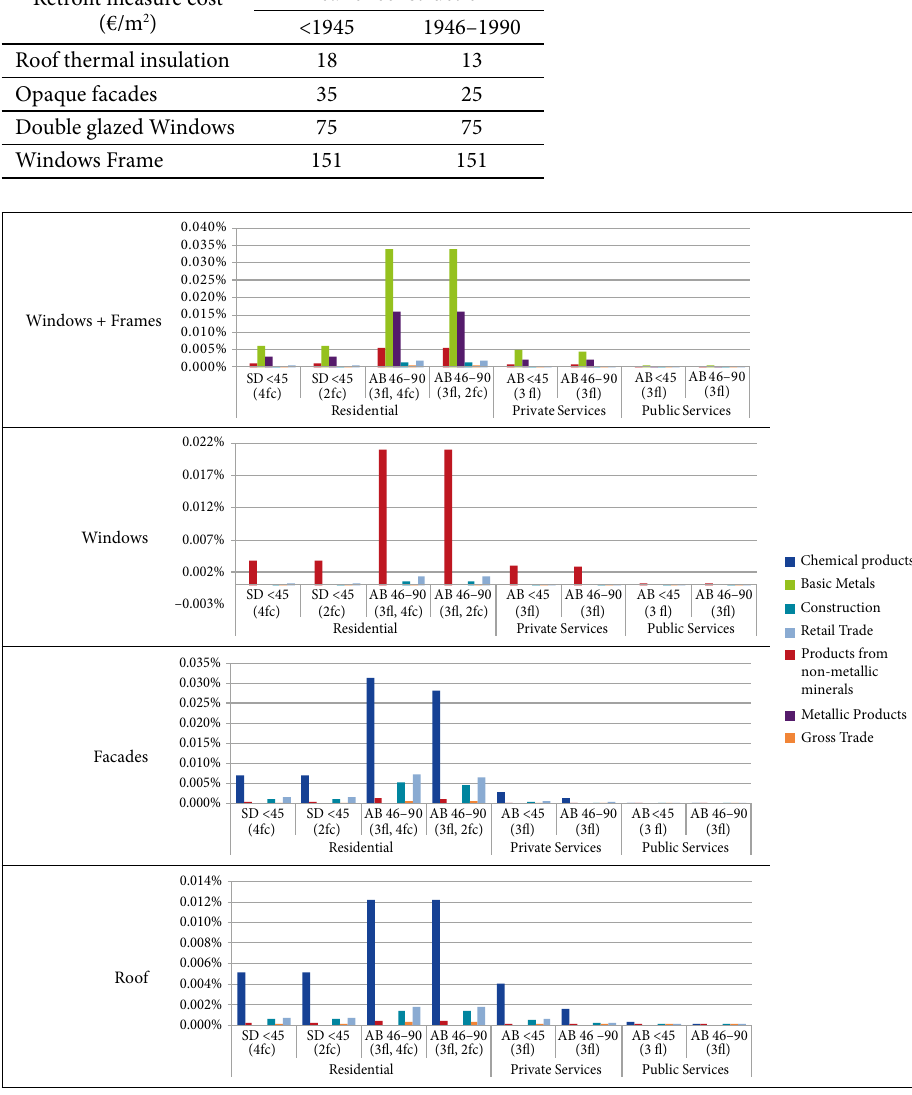
Fig. 1. Retrofit investment allocation to activity